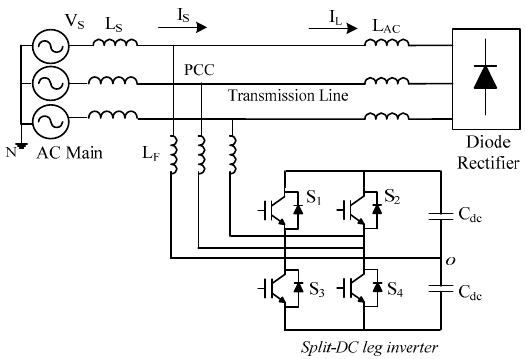
Figure 11. Four-switch DC-split voltage source inverter topology.